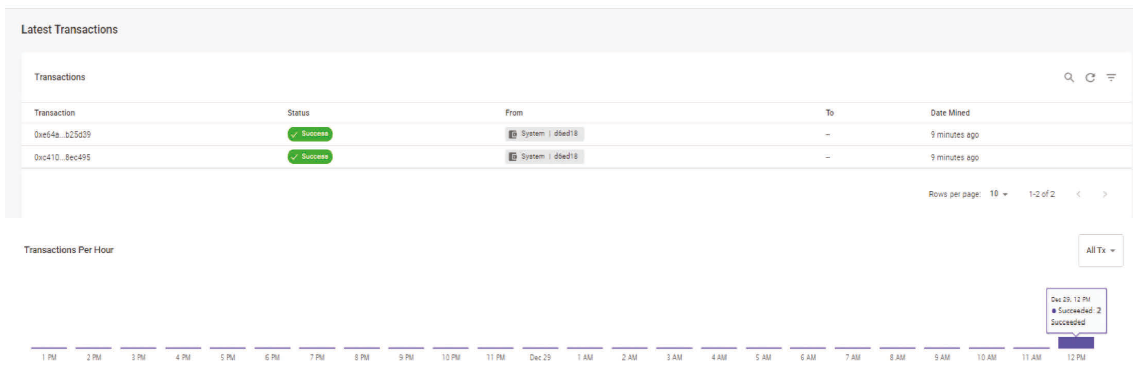
Figure 12: Several successful block node